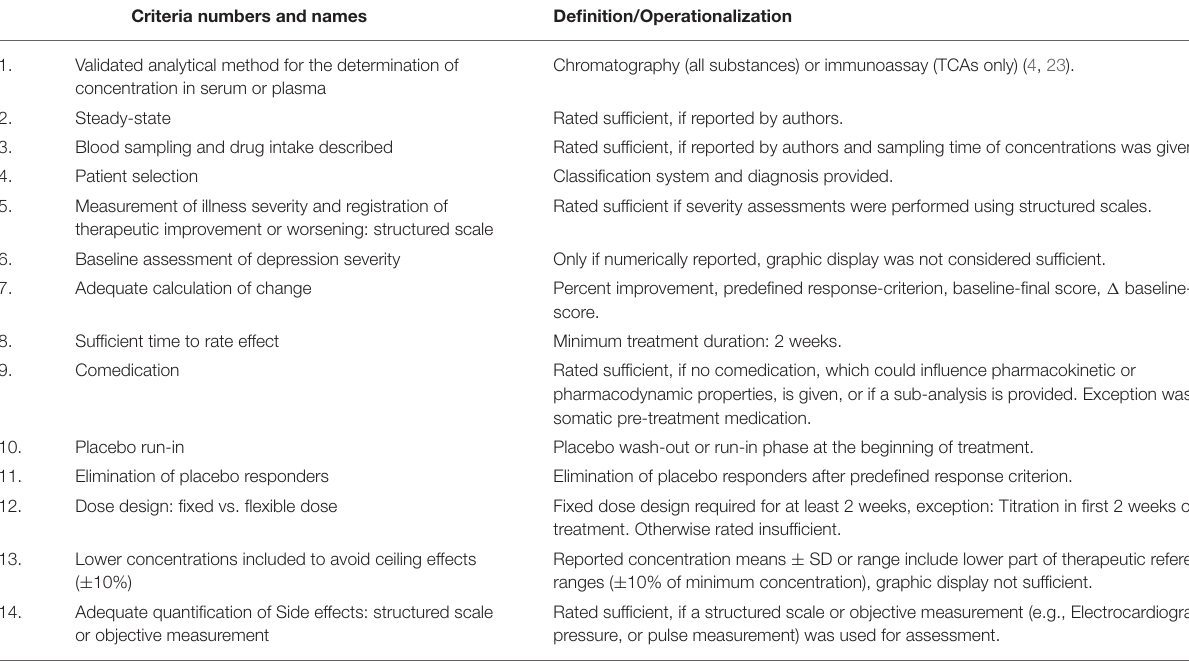
TABLE 2 | Quality assessment